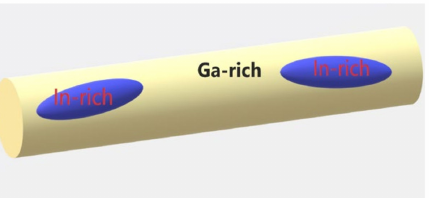
Figure 6. The pore segment loaded with gallium- and indium-rich